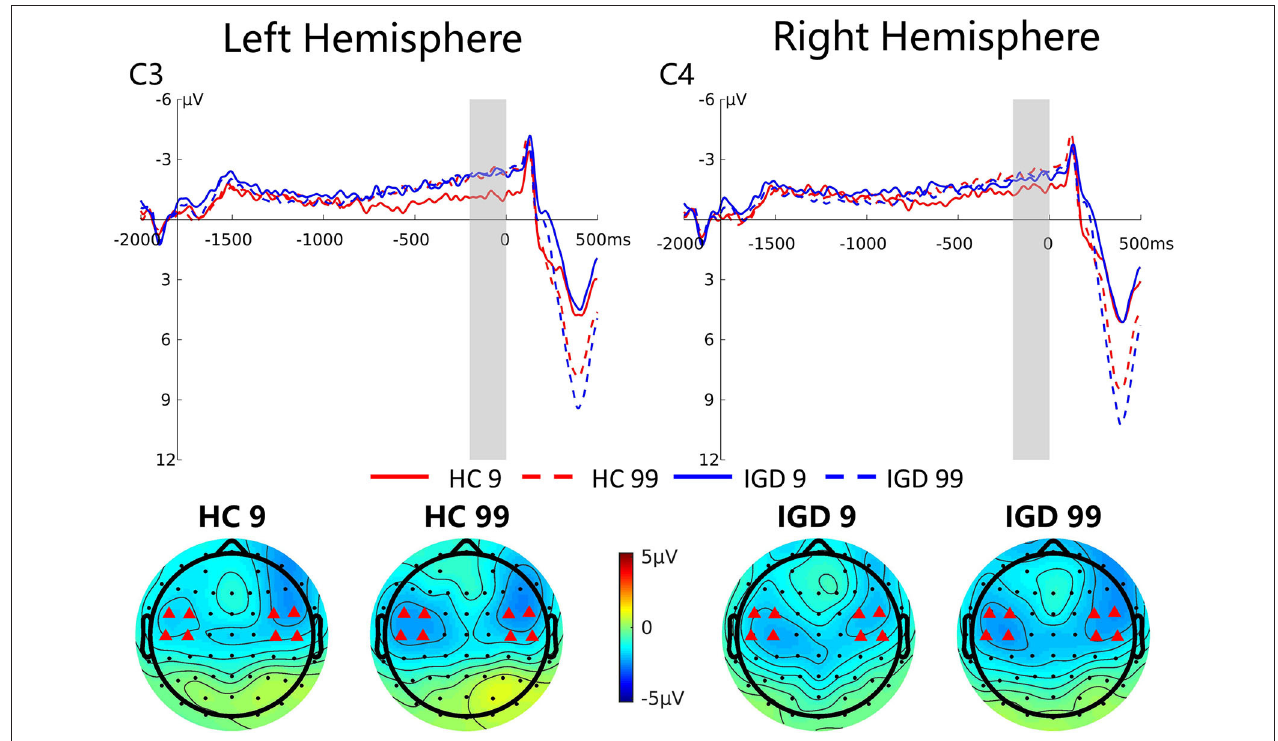
FIGURE 5 | Grand average ERP waveforms following low- and high-risk decisions for HCs and IGDs at C3 and C4. The upper figure shows the ERP waveforms for controls and internet gamer at C3 and C4. The time window was depicted as the shaded areas. The lower figure shows the topographic maps on time window − 200 to 0ms.